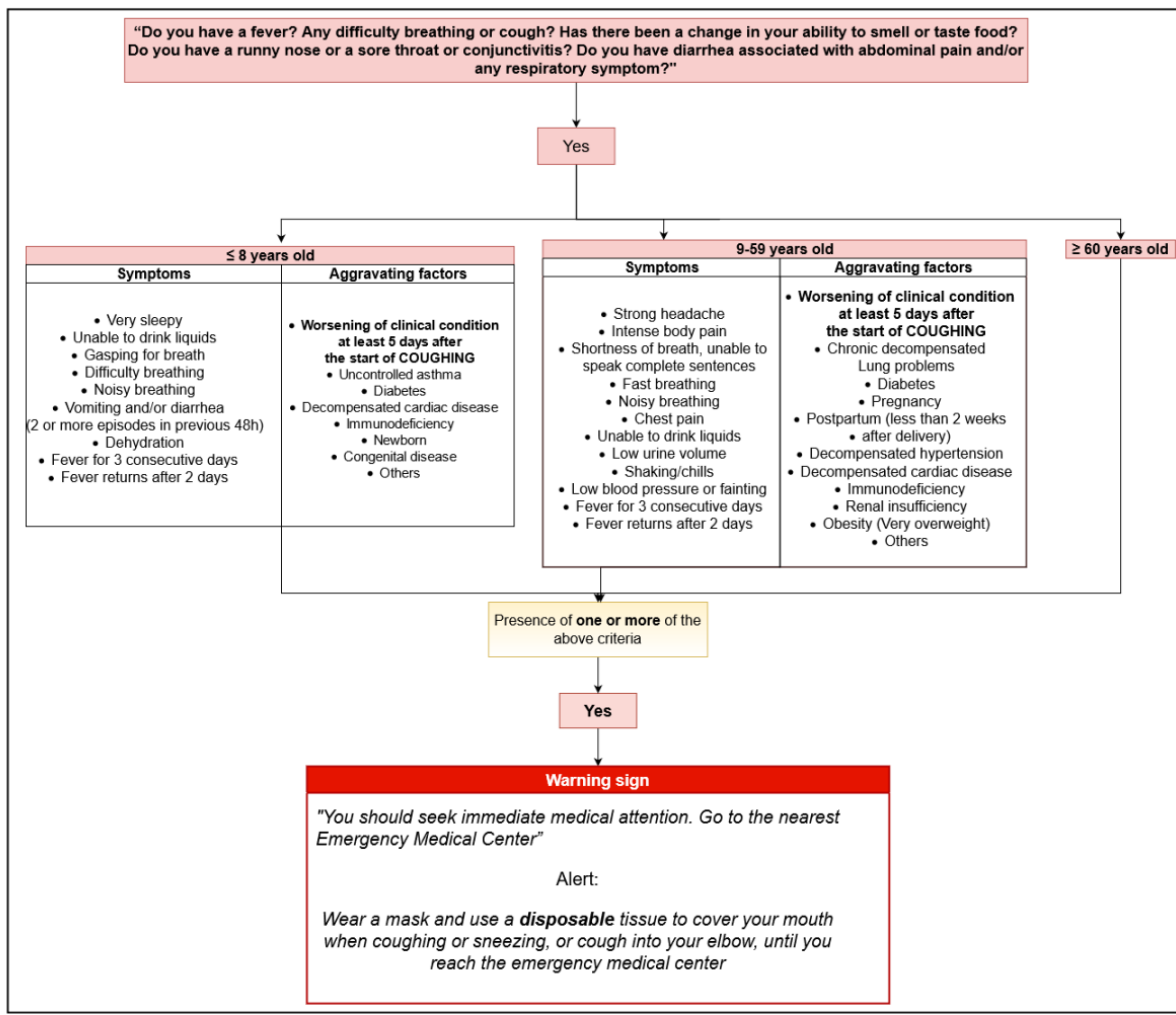
Figure 1. Summary of the Telecoronavirus flowchart used by volunteers, detailing clinical conditions that could lead to potentially poor outcomes (Bahia,